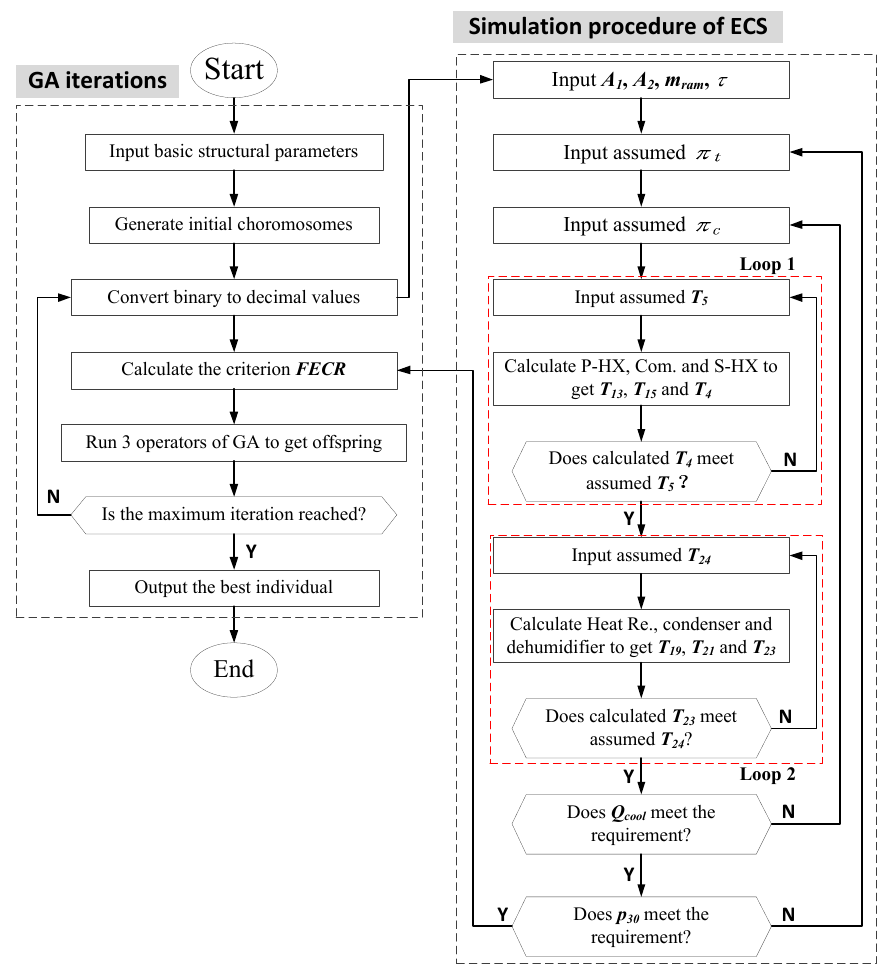
Figure 3. Calculating flowchart of ECS optimization using GA.